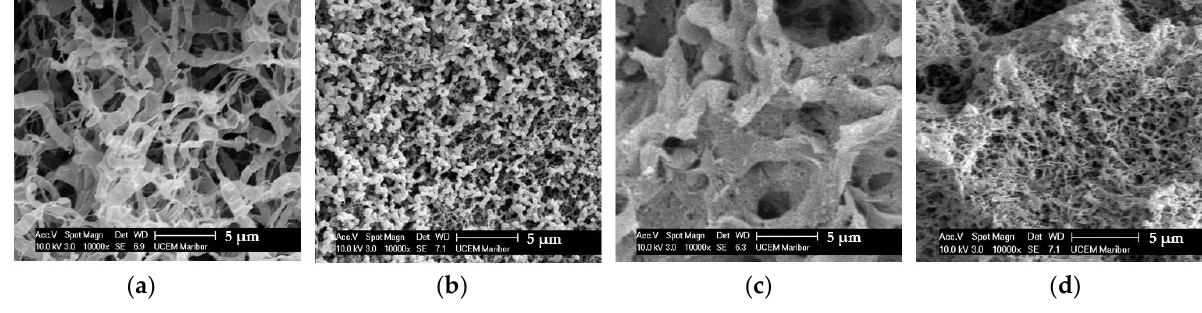
Figure 1. ( a ) FT − IR spectra of P1:PLA1, P1:PLA2, and PLA samples. ( b ) Comparison of FT − NIR